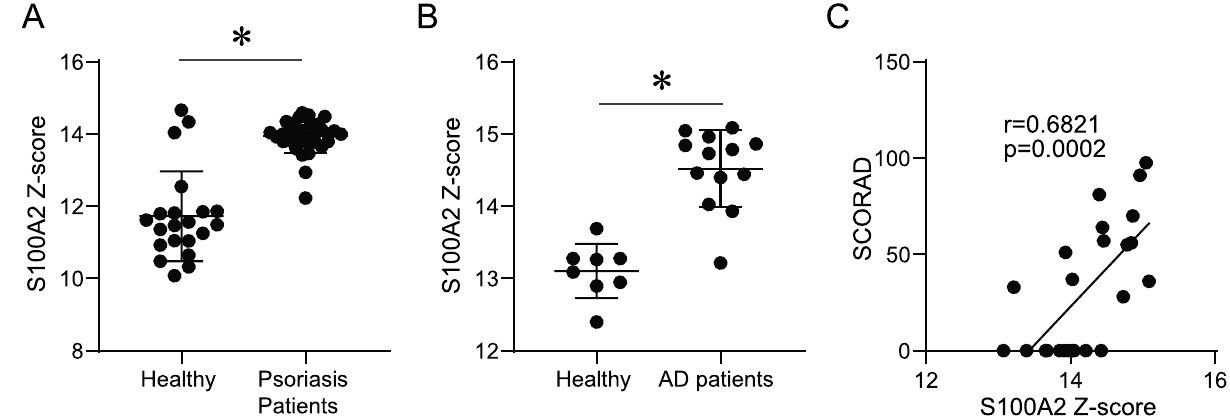
Figure 4. S100A2 expression in inflammatory skin diseases. S100A2 expression in the skin of patients with ( A ) psoriasis and ( B ) AD. Results are expressed as mean ± SD. ( C ) Correlation between SCORAD and the expression of S100A2. All p-values were obtained by the Student’s t -test; *p <